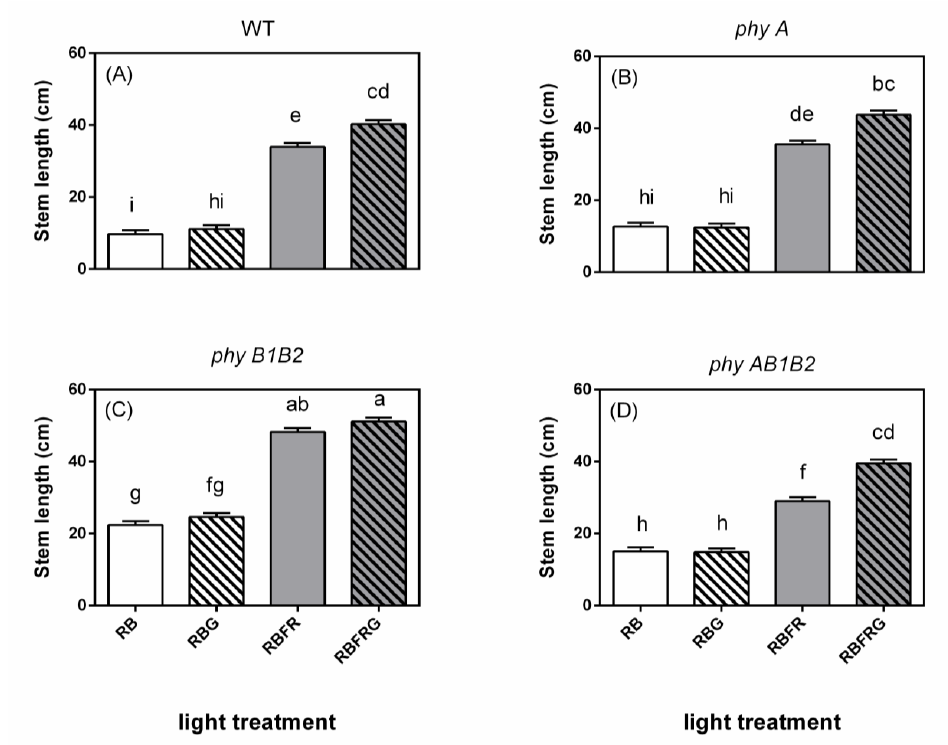
Figure 2. Effect of partial (20%) substitution of red/blue (RB; 3:1) with green (G) light in the presence or absence of far-red light (FR) on the stem length of tomato plants 21 days after treatment. Four genotypes were studied: ( A ) WT (Moneymaker, wild-type), ( B ) phyA (phytochrome A-deficient), ( C ) phyB1B2 (phytochrome B1- and B2-deficient), and ( D ) phyAB1B2 (phytochrome A-, B1-, and B2-deficient). Light treatment and genotype significantly interacted ( p = 0.034). Lower case letters indicate significant differences among the combinations of light treatment and genotype ( p = 0.05), thus also allowing comparisons between panels ( A – D ). Data presented are averages with the SE based on 5 blocks ( n = 5), each containing 9 replicate plants (Exp1).